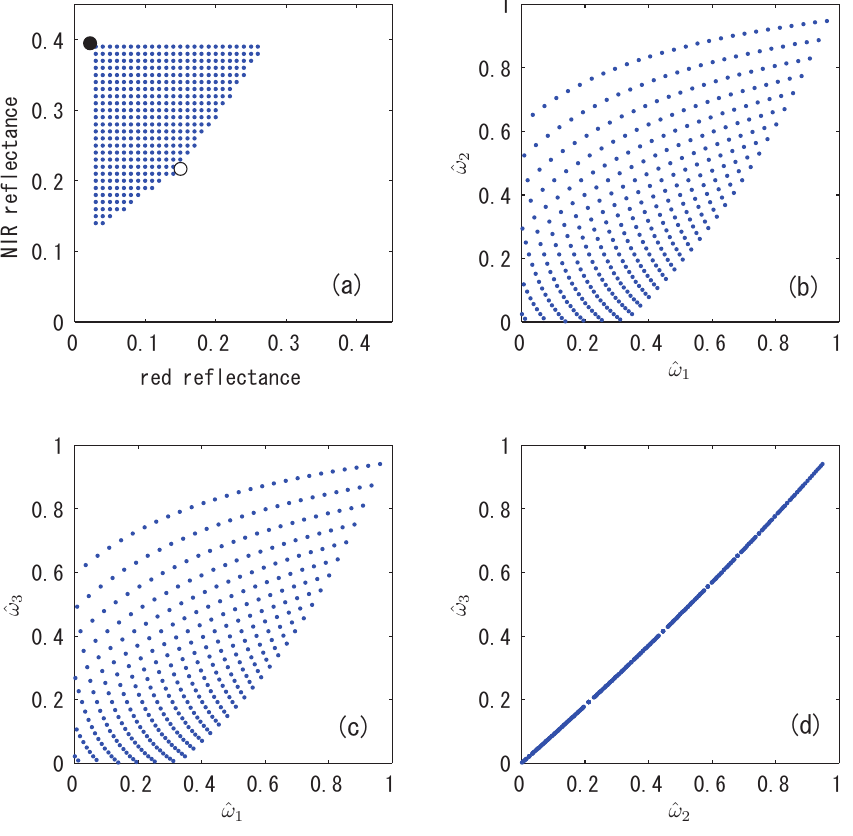
and ^ ω , (c) ^ ω and ^ ω , and (d) ^ ω and ^ ω 2 1 3 1 3 2